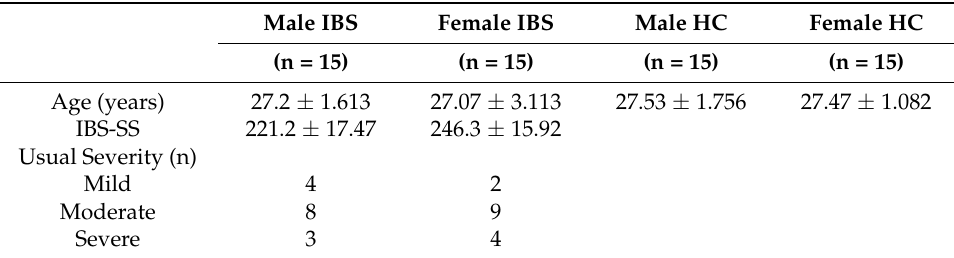
Figure 4. ( a ) Quantification of CRF-RI/II band 1 from immunoblots using plasma of healthy controls (HC) and IBS patients (n = 15/group). Two-way ANOVA showed significant main effect of IBS ( p = 0.0006), but not sex, and no interaction between IBS (disease) and sex was noted. CRFR Band 1 levels increased in male and female IBS patients compared with male HC (Sidak’s multiple comparisons test; n = 15/group). Male IBS vs. Male HC, p = 0.028 and Female IBS vs. Male HC, p = 0.0108. ( b ) Quantification of CRFR Bands 1–6 (total bands) from immunoblots from plasma of healthy controls (HC) and IBS patients (n = 15/group). Two-way ANOVA showed no significant main effect of IBS or sex. No significant difference in total CRFR levels between IBS and HC were noted. ( c ) Linear regression revealed a significant inverse association between IBS-SS and B7-2 band 5 ( p = 0.0492) with an increase in disease severity resulting in decreased B7-2 levels. Table 1. Characteristics of IBS and healthy controls (HC).